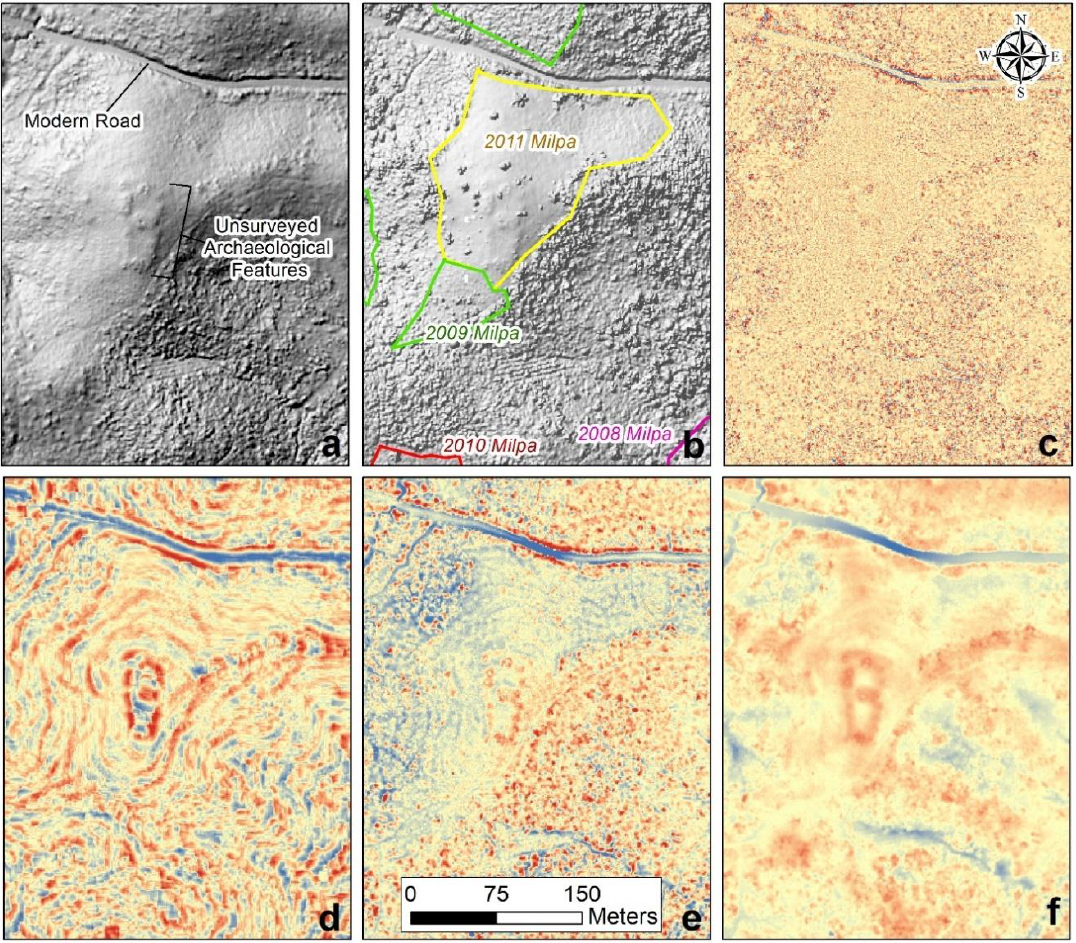
Figure 5. TPI results of a newly identified plazuela on ( a ) the bare earth model (Digital Terrain Model (DTM)) hillshade, ( b ) the DSM with annual milpas emphasized, and ( c – f ) TPI results. Input parameters for TPI: TPI raster calculator method, using ( c ) 10x10 cells; ( d ) topography tool (TT) height of 2 and width of 10; ( e ) topography tool (TT) height of 10 and width of 10; and ( f ) topography tool (TT) height of 33 and width of 33.